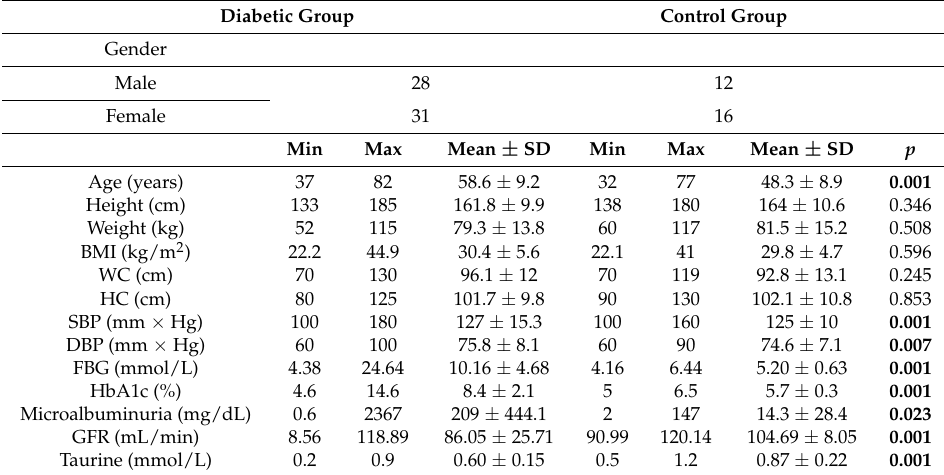
Table 1. Demographic, clinical and laboratory features of control and diabetic